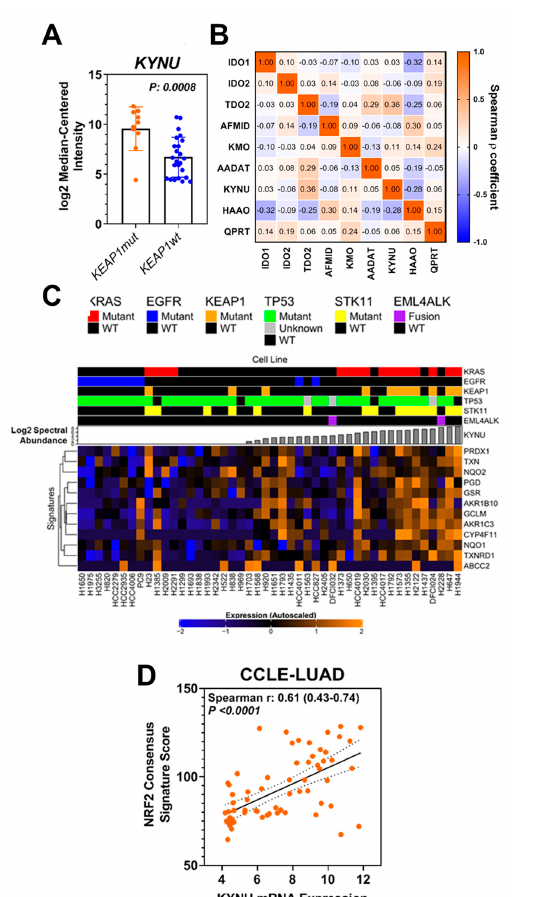
Figure A2. Association between KYNU and tryptophan-kynurenine pathway metabolites and KEAP1 mutation status in LUAD cell lines. ( A ) mRNA expression of KYNU in LUAD cell lines stratified by KEAP1 mutational status. Gene expression was derived from the Cancer Cell Line Encyclopedia (CCLE) database and overlapped with cell lines for which proteomic data was available. ( B ) Heatmap depicting Spearman correlation coefficients between CCLE ‐ derived mRNA expression of KYNU and associated tryptophan ‐ kynurenine pathway ‐ related enzymes among LUAD cell lines. ( C ) Heatmap representing protein expression of NRF2 ‐ downstream targets including those detected proteins that comprise the consensus panel described by Best et al. [13] among 47 LUAD cell lines. Columns are ranked (lowest to highest) by KYNU protein expression. ( D ) Scatter plot illustrating the association between CCLE ‐ derived KYNU mRNA expression and a 10 ‐ gene NRF2 activation consensus signature described by Best et al. [13] among LUAD cell lines. A regression line and associated 95% confidence intervals is shown.